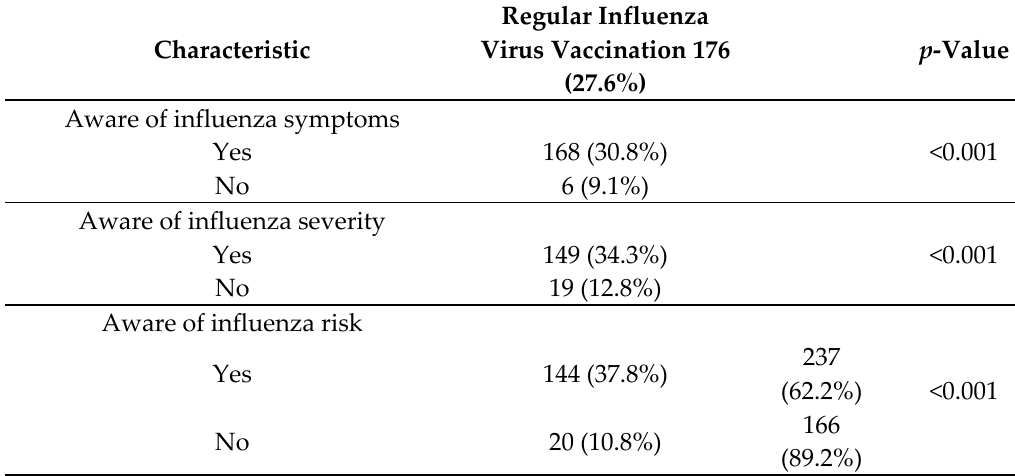
Table 4. Knowledge, attitude and practice of influenza